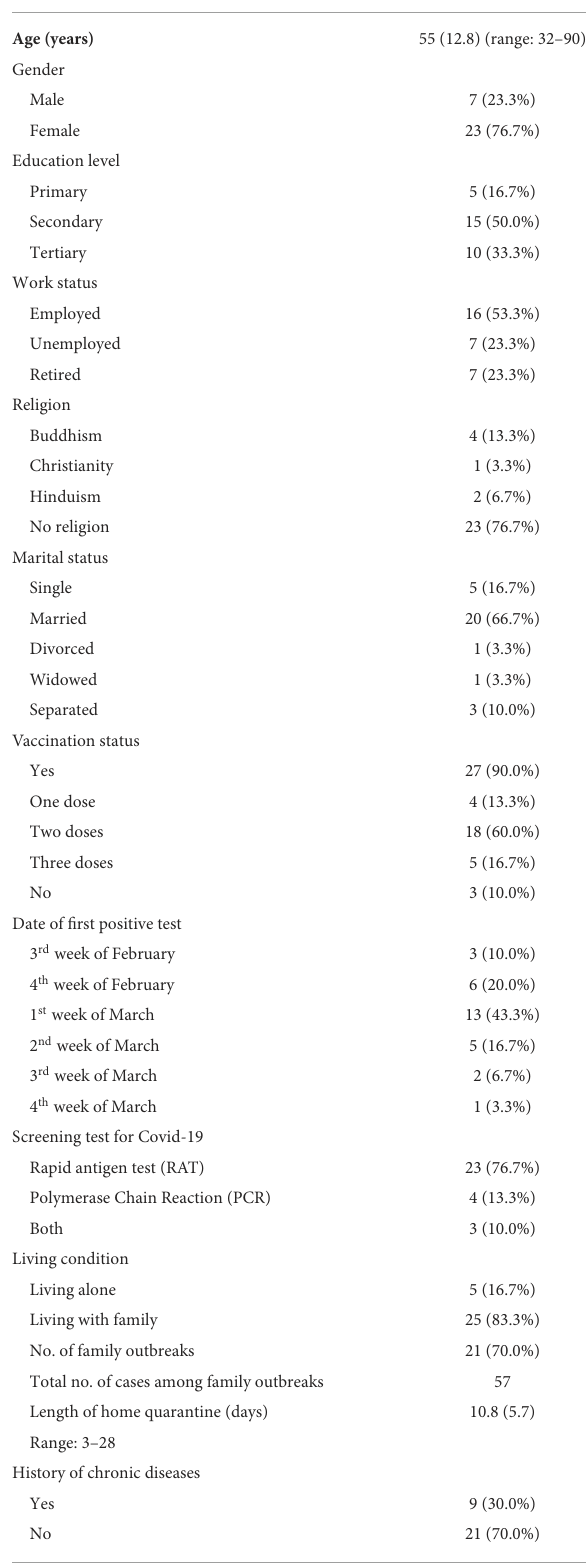
TABLE 1 Characteristics of the